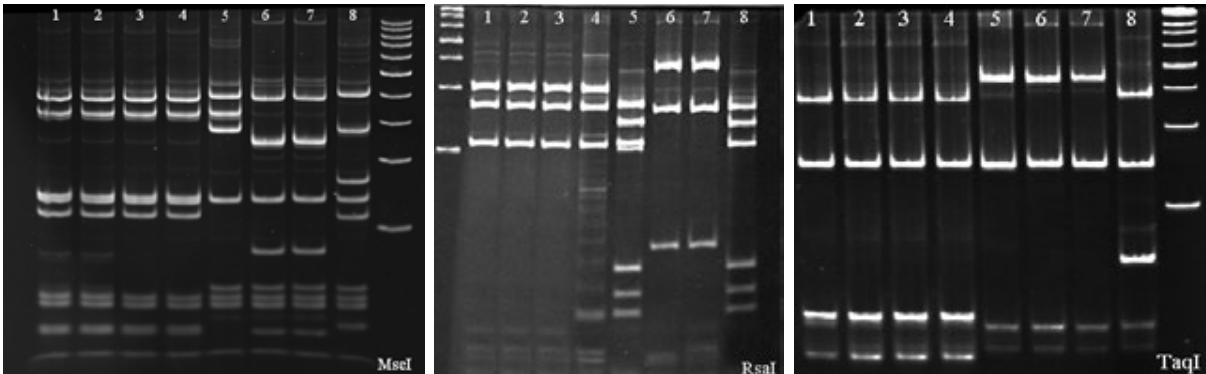
Figure 2. Polyacrylamide gel (5%) showing the RFLP profiles obtained from R16F2n/R16R2 - nested PCR amplicons after digestion with Rsa I, Taq I, and Mse I restriction enzymes. Lanes 1-3: symptomatic Argyranthemum frutescens samples GN4, GN5, GN6; lane 4: Picris echioides yellows (PEY, 16SrIX-C); lane 5: severe aster yellows (SAY, 16SrI-B); lane 6: elm yellows (EY, 16SrV-A); lane 7: “flavescence dorée” (FD, 16SrV-C); lane 8: “stolbur” (STOL, 16SrXII-A). DNA marker: GeneRuler TM 100 bp DNA Ladder (Fermentas).